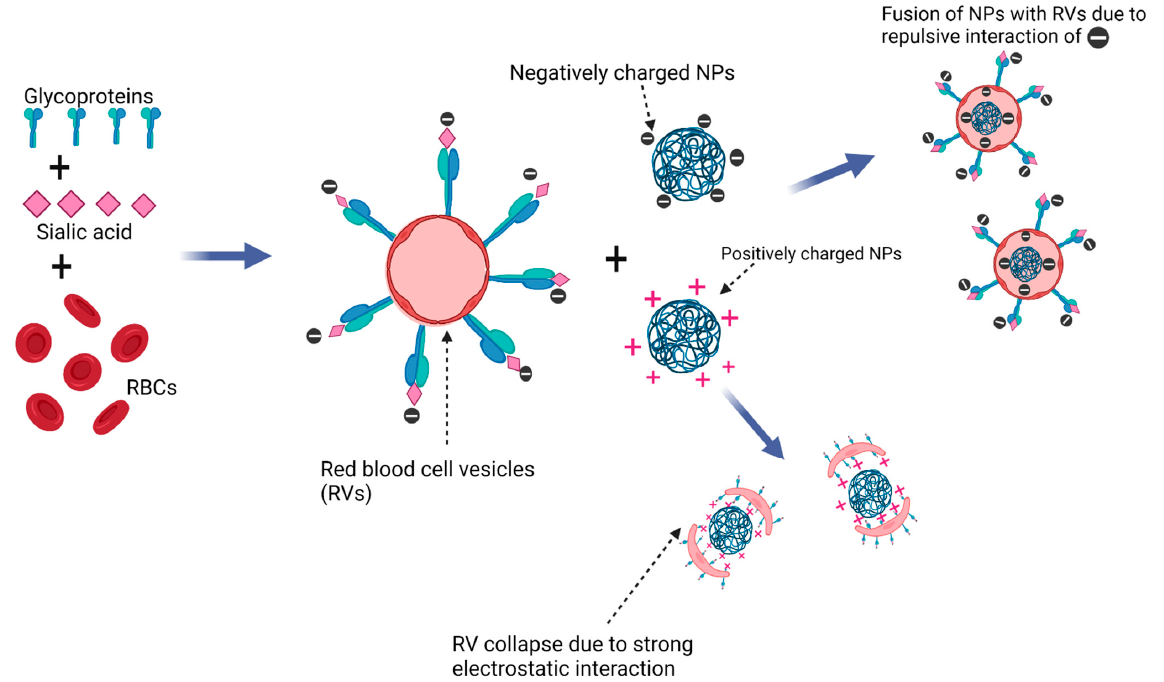
Figure 3. Preparation of RBC vesicle-coated nanoparticles. Schema of electrostatic interactions between negatively and asymmetrically charged RVs (red blood cell vesicles) with negatively charged nanoparticles on one side and positively charged ones on the other. First, the RBCs are designed to form negatively charged vesicles by the addition of glycoproteins and sialic acid. Secondly, the RVs are then mixed with positively and negatively charged nanoparticles, respectively, with their embedded payloads. Naturally, the negatively charged nanoparticles strongly repulsed the negatively charged RVs; however, fusion was achieved by co-extrusion, where mechanical force drives the nanoparticles through the lipid bilayer to fuse with the intracellular membrane side of RBCs. The strong affinity between the positively charged nanoparticles and the negatively charged RVs led to the collapse of the lipid bilayer, which prevented nanoencapsulation. Modified from (Ref [98]) and Created with BioRender.com. Accessed 24 October 2021.